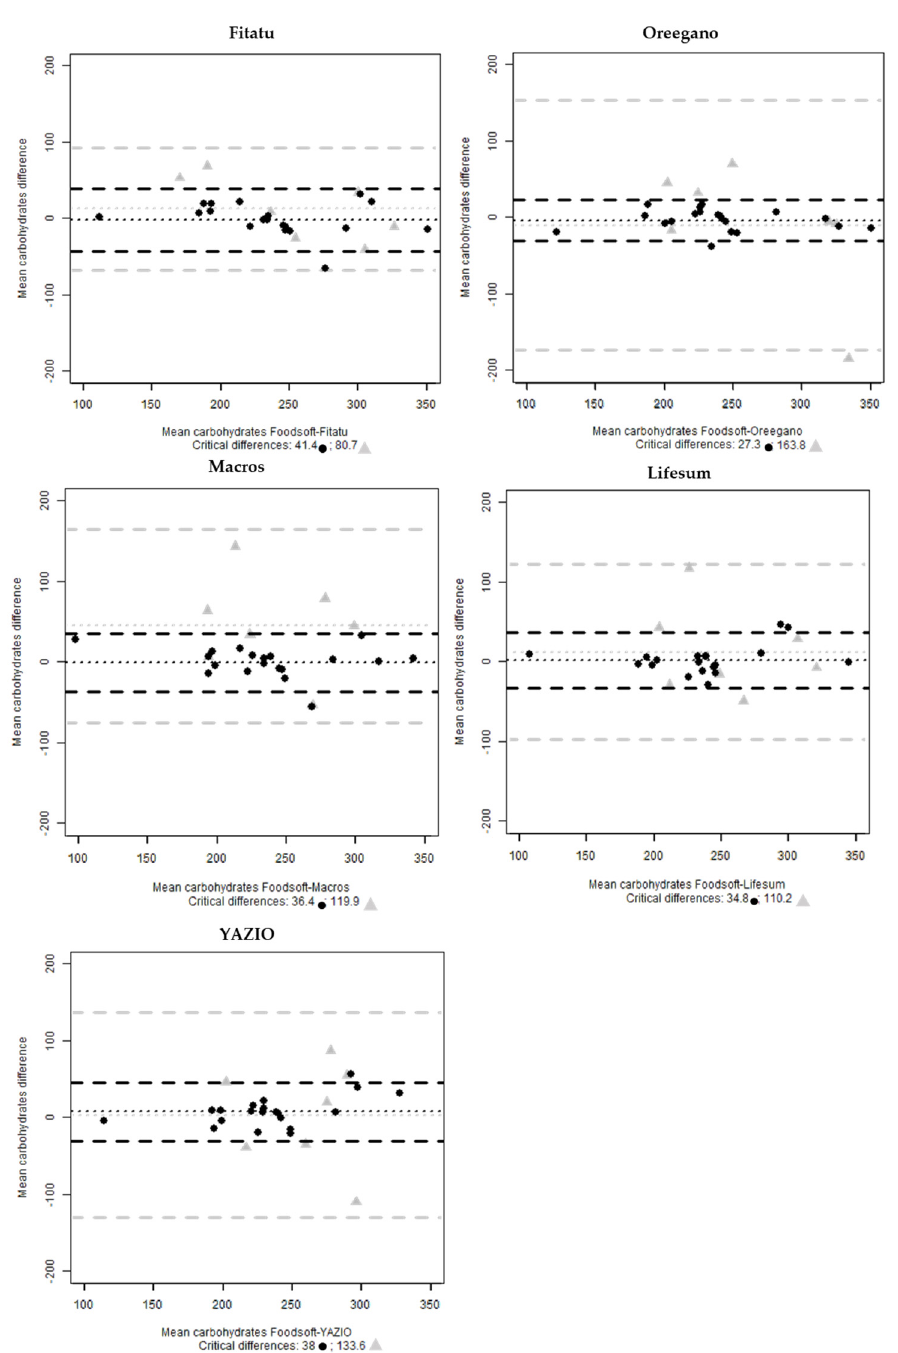
Figure 4. Bland-Altman plots of mean carbohydrates (g) difference between Foodsoft 1.0 and Fitatu, Oreegano, Macros, YAZIO and Lifesum whole sample ( ● ) and the selected 24-HRs ( ).